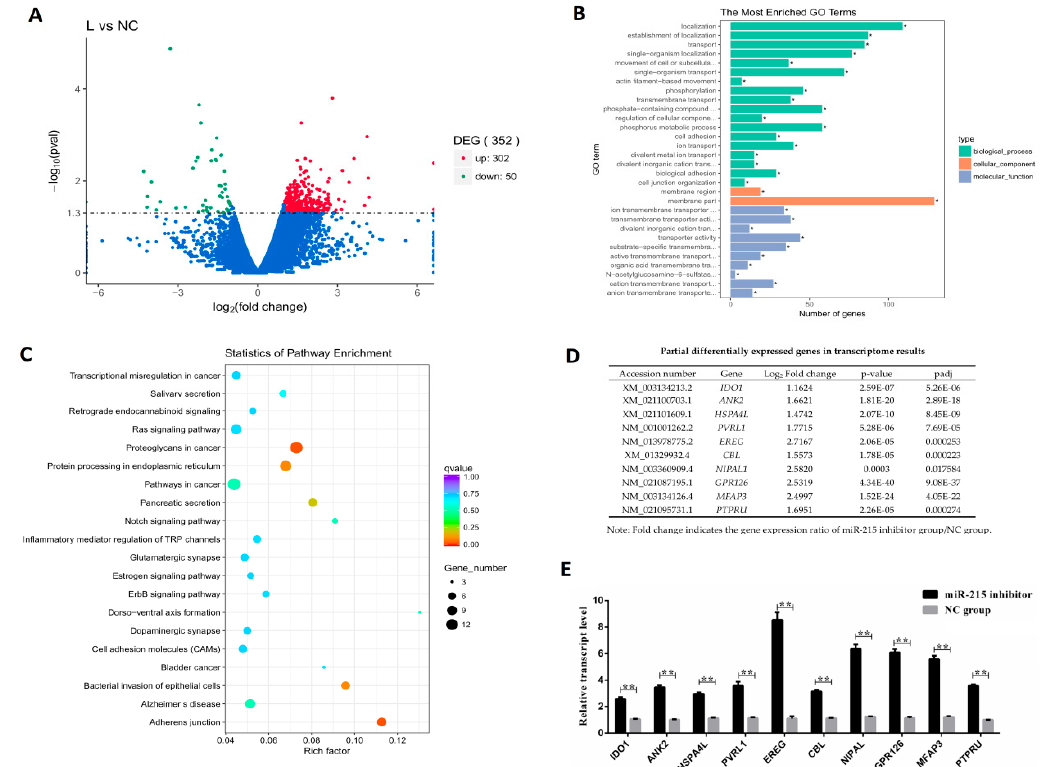
Figure 3. Transcriptome sequencing results and qPCR verification of partial differential genes. ( A ) Volcano plot of differentially expressed genes (DEGs) between miR-215 inhibitor group and NC group. Genes with significant differential expression are indicated by red dots (up-regulation) and green dots (down-regulation), and genes with no significant differential expression are indicated by blue dots. The abscissa represents the fold-change of gene expression in different samples. The ordinate represents the statistical significance of the difference in the amount of change in gene expression. L, miR-215 inhibitor group; NC, negative control group. ( B ) GO enrichment histogram. The ordinate shows the enriched GO term and the abscissa shows the number of differential genes in the term. Different colors are used to distinguish biological processes, cellular components, and molecular functions; * indicates significantly enriched GO term. ( C ) KEGG enrichment scatter plot of differential genes. The vertical axis shows pathway names and the horizontal axis shows rich factor. The size of the dots indicates the number of differential genes in the pathway, and the color of the dots corresponds to a different Qvalue range. ( D ) Partial differentially expressed gene (DEGs) in transcriptome results. ( E ) Differentially expressed genes (DEGs) detected by qPCR. ** indicates significant difference ( p < 0.01). 3.3. Prediction and Verification of miR-215 Target Genes Combined with the DEGs of sequencing and the predicted results, the candidate target genes for miR-215 were initially screened as EREG , NIPAL1 and PTPRU . The recombinant plasmids pMIR- Report of miR-215 target genes were constructed and validated by Sanger sequencing (Figure S1). The results showed that miRNA-215 mimics showed significant inhibition on EREG and NIPAL1 ( p < 0.05), and showed significant inhibition on PTPRU ( p < 0.01); miRNA-215 inhibitor showed significant enhancement for EREG and NIPAL1 ( p < 0.05), and showed significant enhancement for PTPRU ( p < 0.01) (Figure 4A). qPCR was used to detect the expression of miR-215 target genes ( EREG , NIPAL1 and PTPRU ) in the duodenum of E.coli F18-resistant and sensitive Sutai weaned piglets. The results showed that the expression levels of EREG and PTPRU genes in resistant individuals were significantly higher than